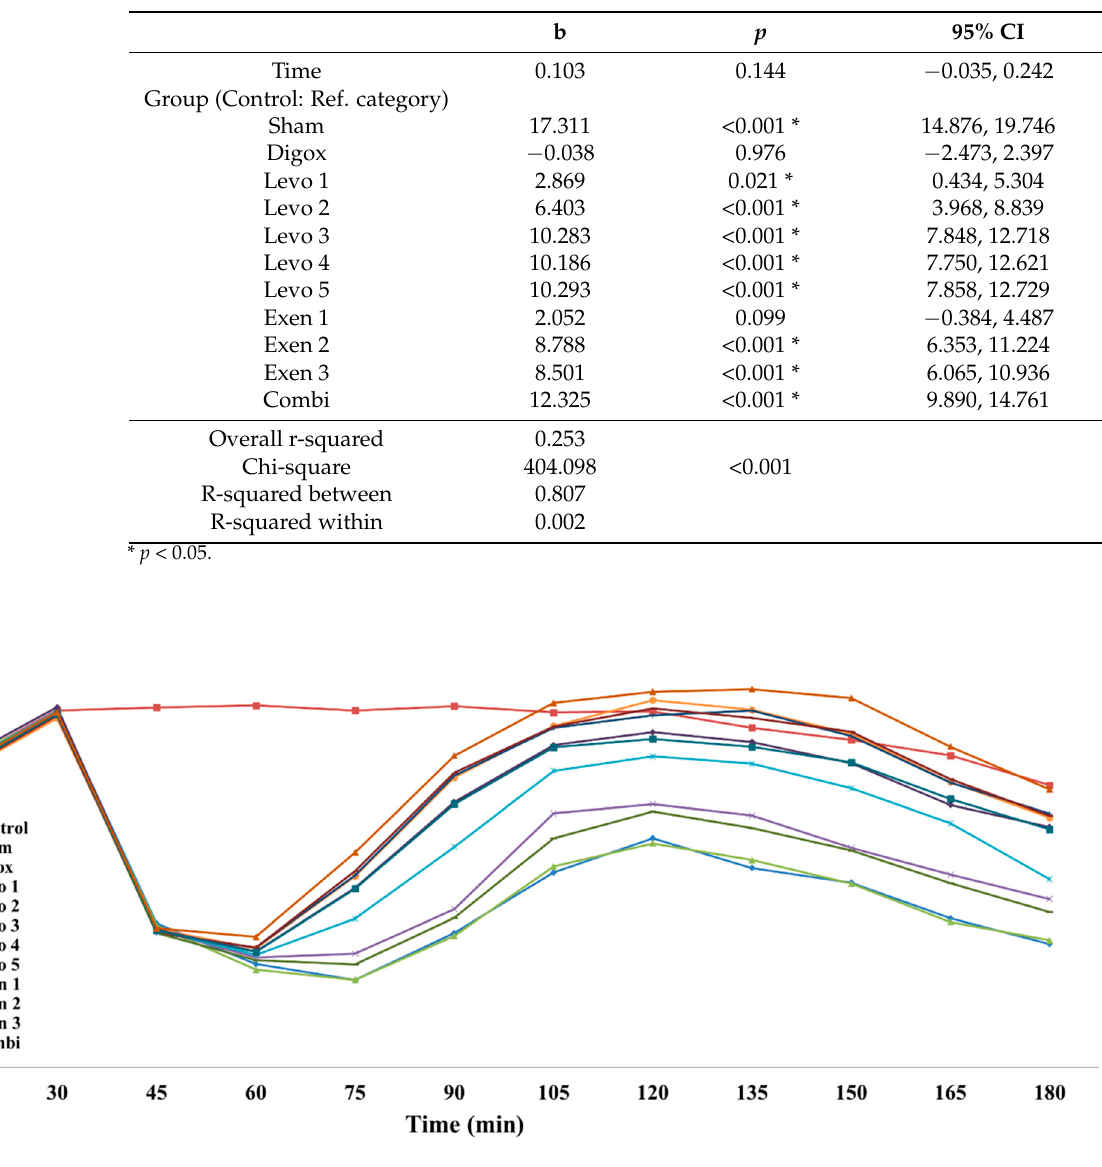
Table 5. Longitudinal analysis for RPP for all groups.